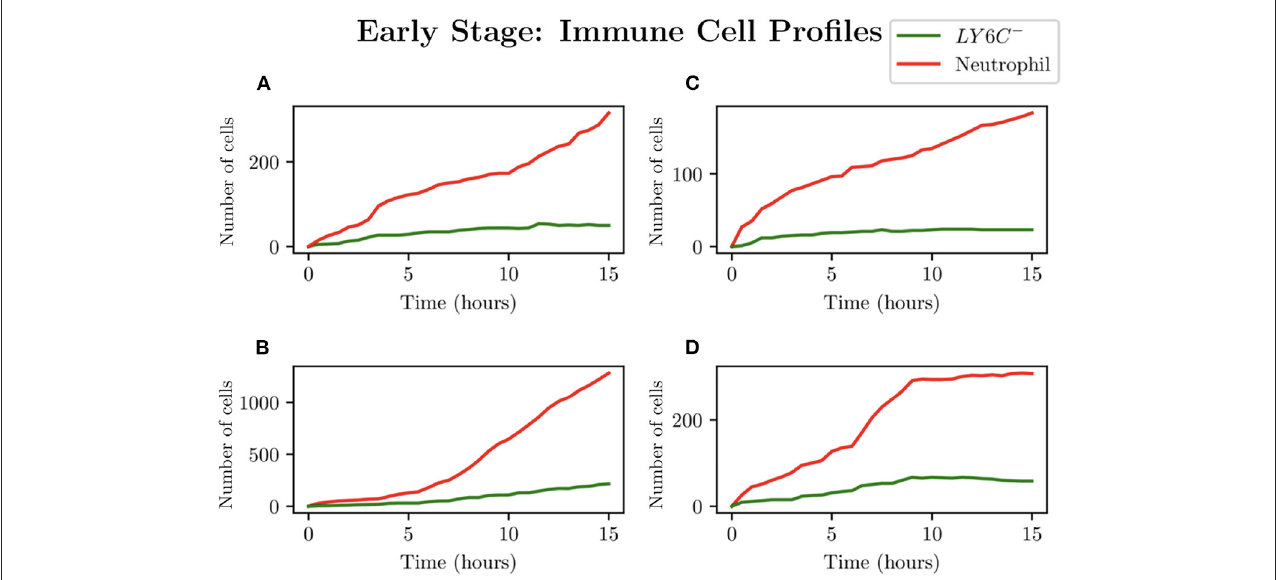
FIGURE6 Simulations (A–D) represent the neutrophil and helper macrophages ( LY 6 C − ) profiles arising from the case I B = 1. The specific simulations correspond to those shown in Figure 5.